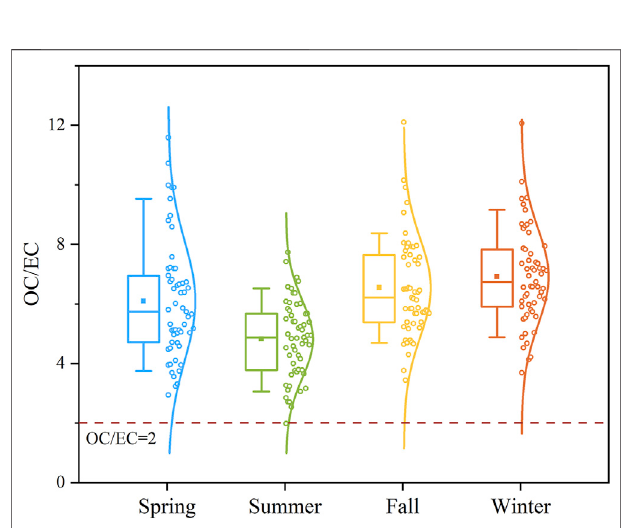
FIGURE 2 | Total cation versus anion micro-equivalents concentrations in four seasons: (A) spring, (B) summer, (C) fall and (D) winter.